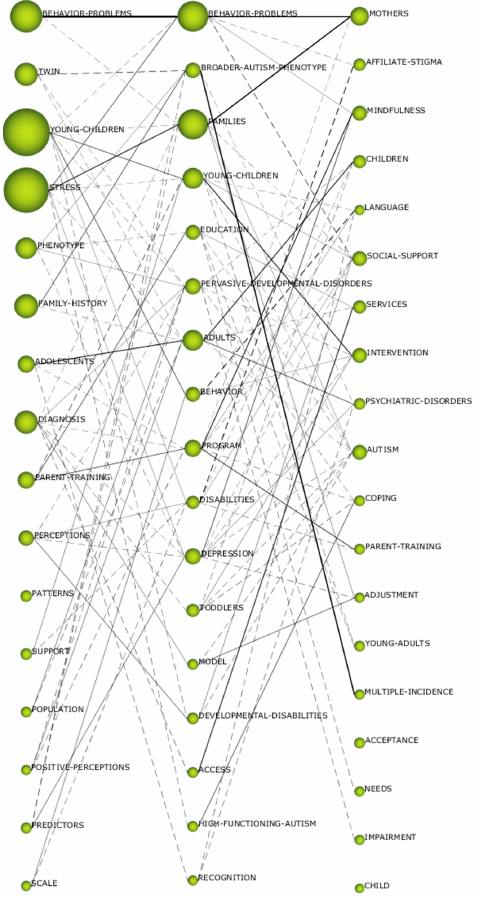
Figure 5. Thematic evolution by h-index.